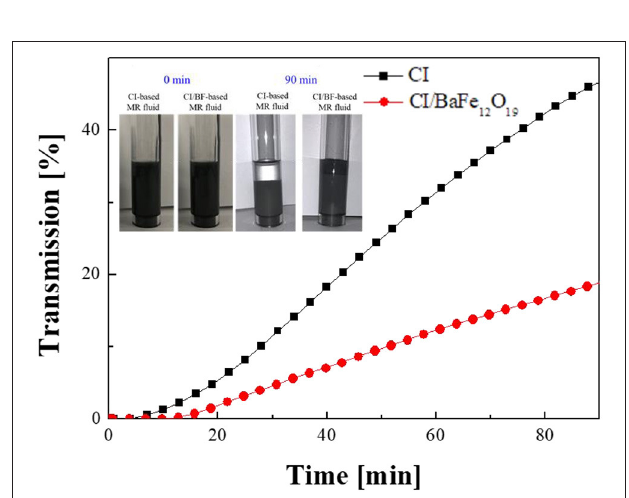
FIGURE 9 | Sedimentation stability curve verse time for pure carbonyl iron (CI; square symbol) and CI/BaFe 12 O 19 mixture-based MR fluids (circle